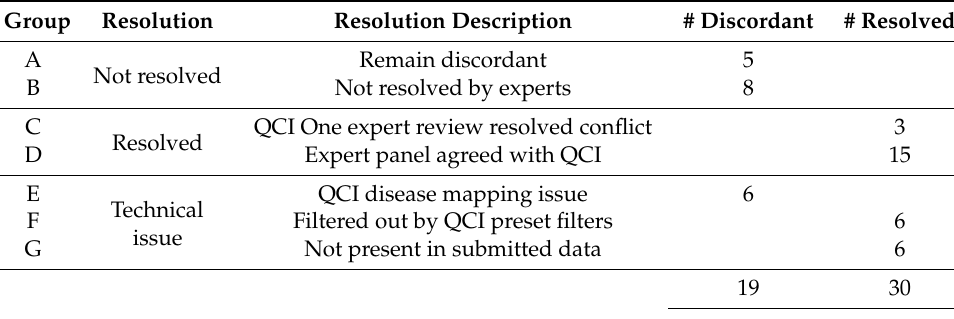
Table 2. Classification discrepancies in hematologic